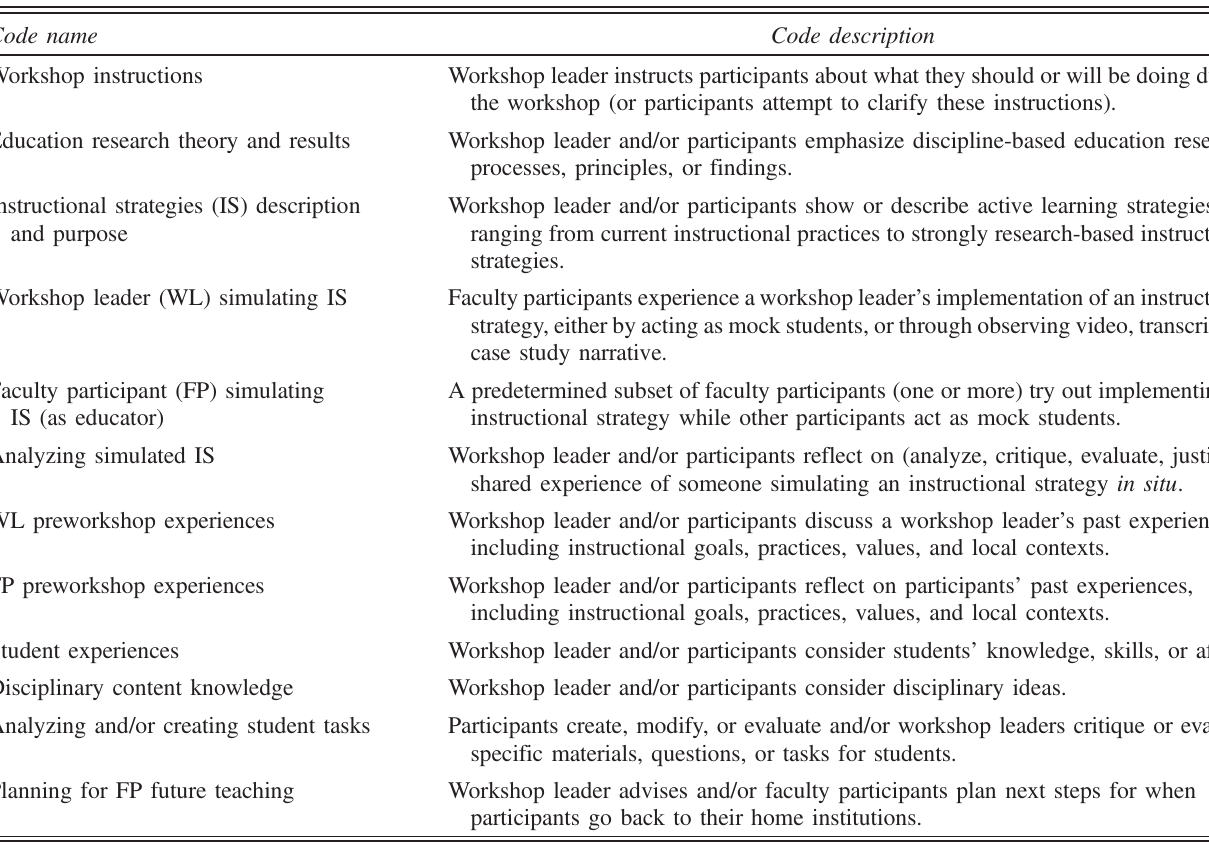
TABLE III. Focus-of-engagement code names and brief